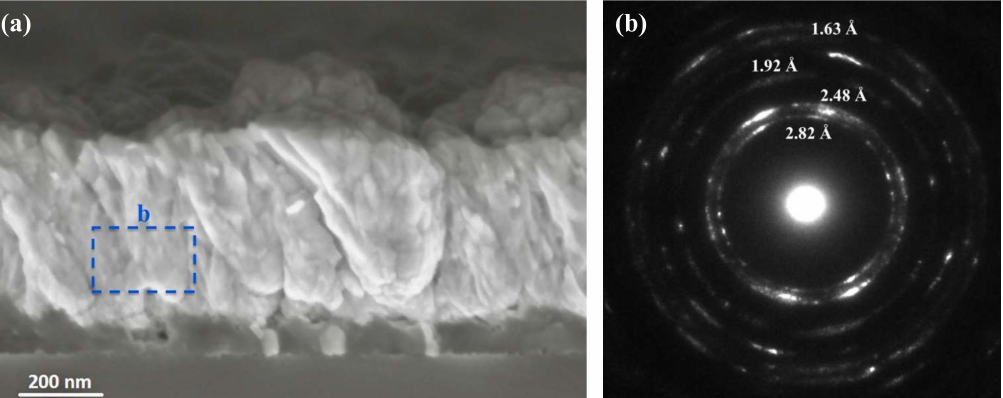
Figure 6. ( a ) SEM analysis in cross view of 500 nm AZO thick sample. ( b ) Diffraction pattern by electron beam carried out on to an area of the AZO layer as indicated by the dashed box in ( a